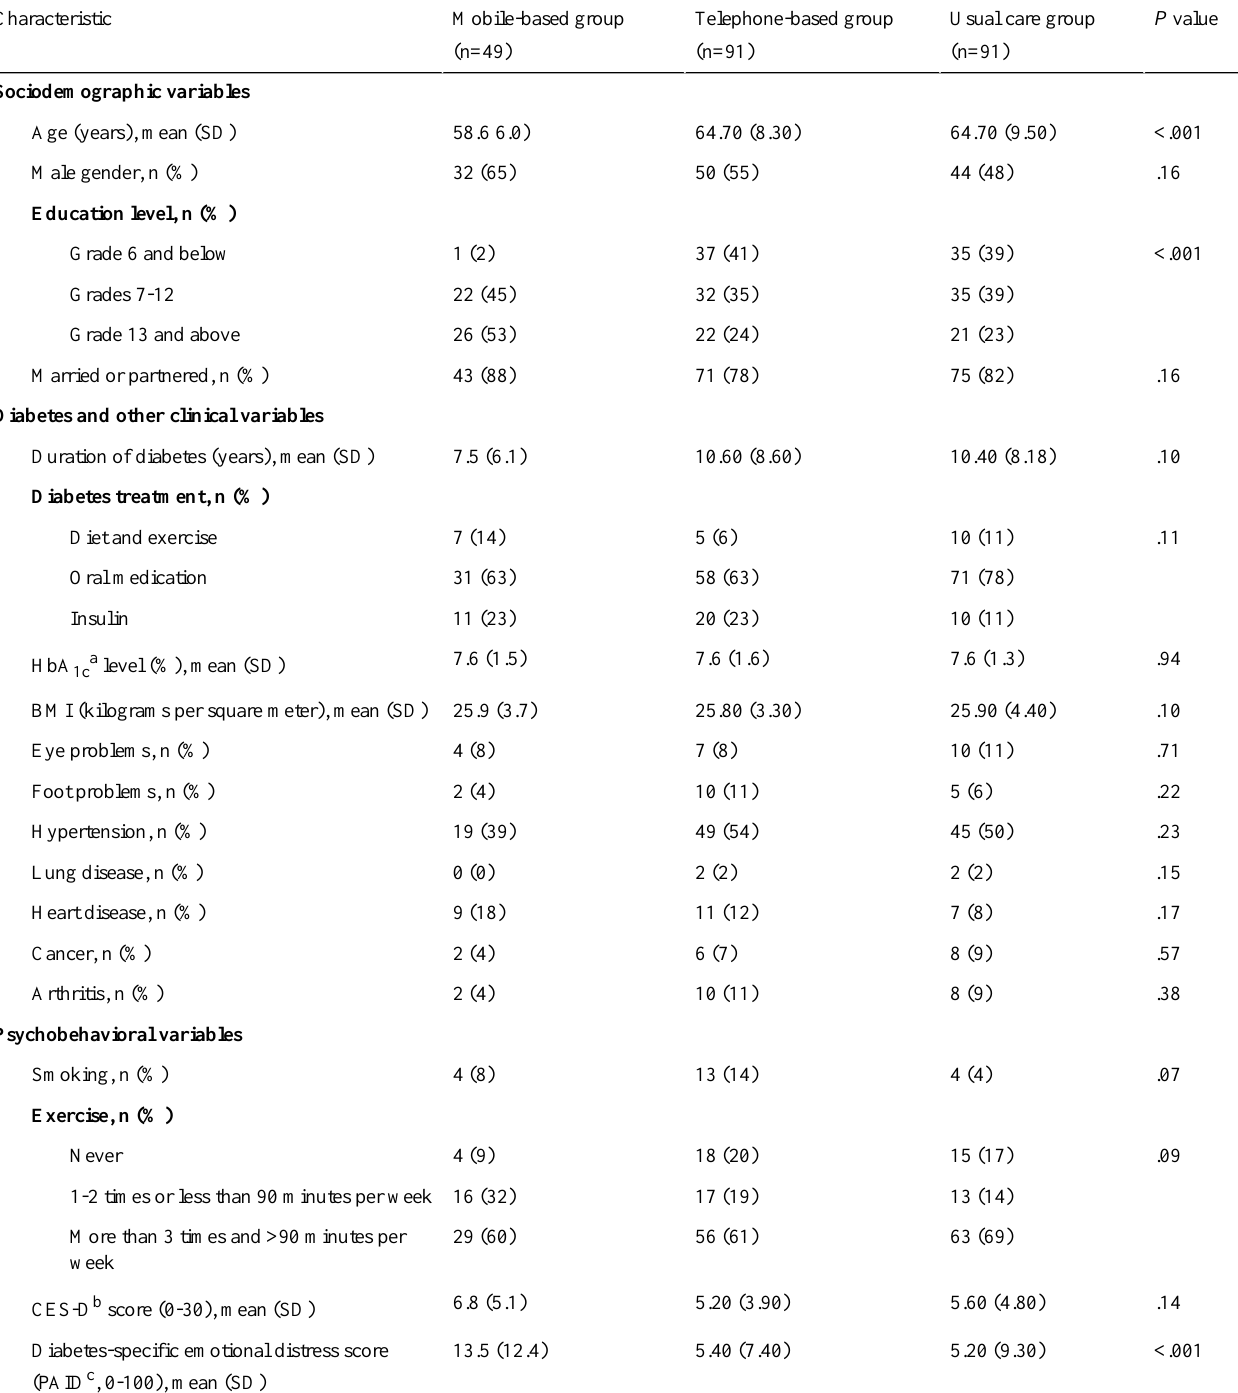
Table 1. The baseline sociodemographic, clinical, and psycho-behavioral characteristics of the mobile-based, telephone-based, and usual care groups